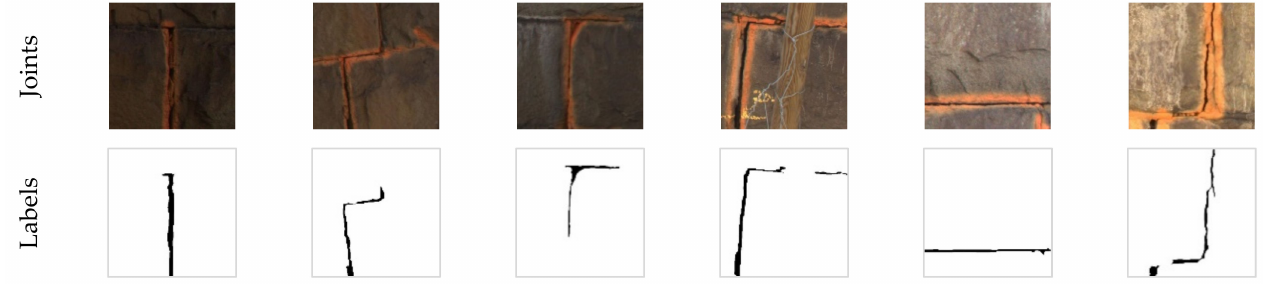
Figure 8. Examples of the prepared dataset used for pixel-wise damage